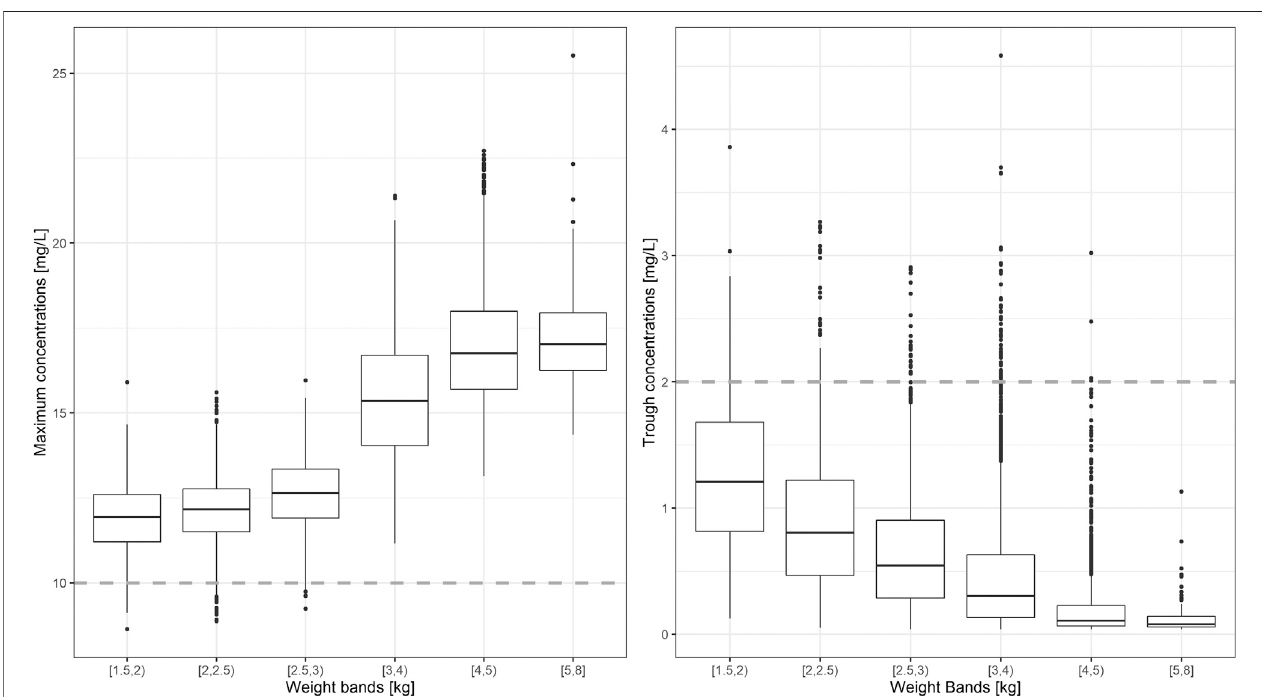
FIGURE 4 | Predicted gentamicin peak (left) and trough (right) concentrations in sepsis patients aged between 0 and 59 days. Estimates are summarized accordingtotheweight-bandsusedintheoriginalAFRINEST/SATTtrials.Hingesrepresent25 th and75 th percentiles(respectively,Q1andQ3),whiskersrepresentQ1 − 1.5IQR and Q3 + 1.5IQR, respectively, where IQR is the interquartile range. All the subjects outside this range are represented by the dots ( N (cid:1) 9,994). Dashed lines represent the threshold values for peak and trough concentrations of 10 and 2 mg/L, respectively.